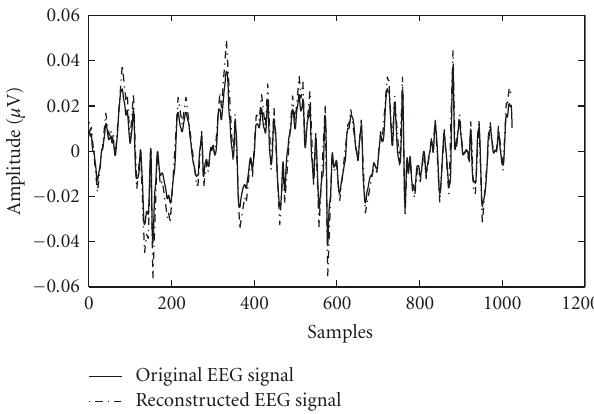
Figure 8: A comparison between the original EEG signal and its reconstruction. PRD = 34 . 35%,CC = 98 . 43%,RMSE = 0 . 0046, and MAXERR = 0 . 0187.